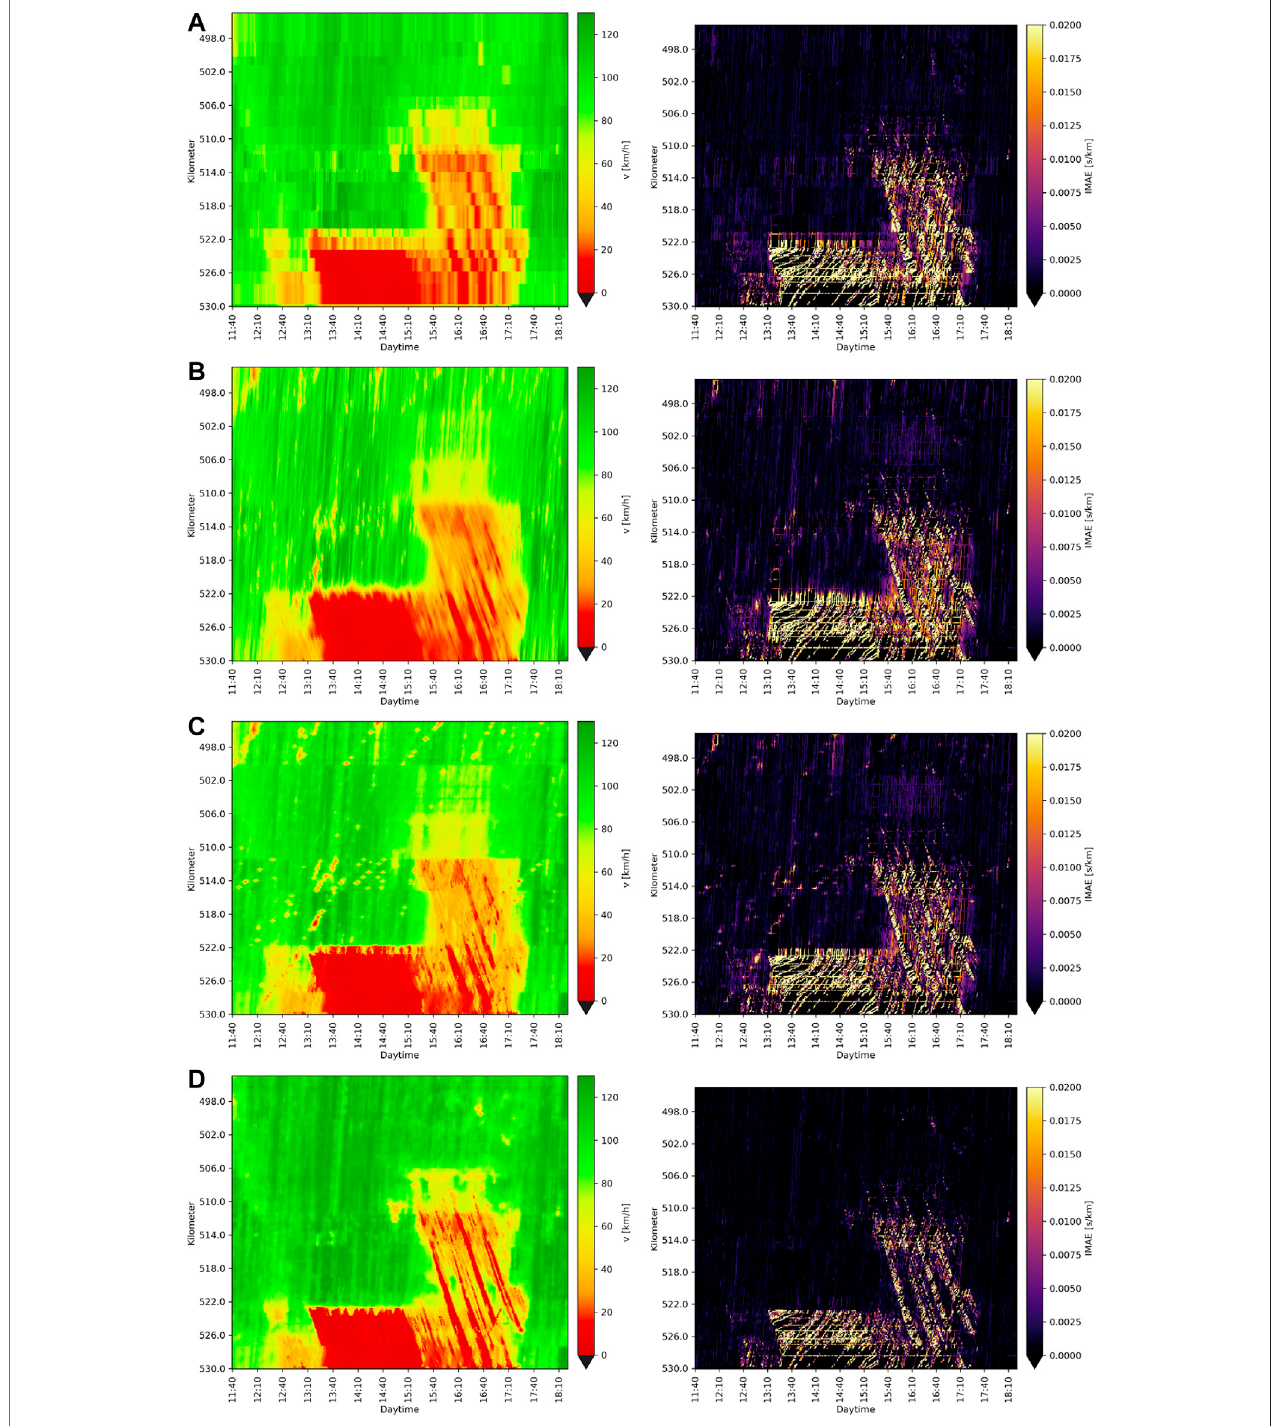
FIGURE 6 | Reconstructed speeds applying each algorithm (A) SEC-AVG, (B) ASM, (C) PSM, (D) PSM-W to the training data (on the left) and resulting IMAEs comparing the reconstructed speeds to all available data (right) .